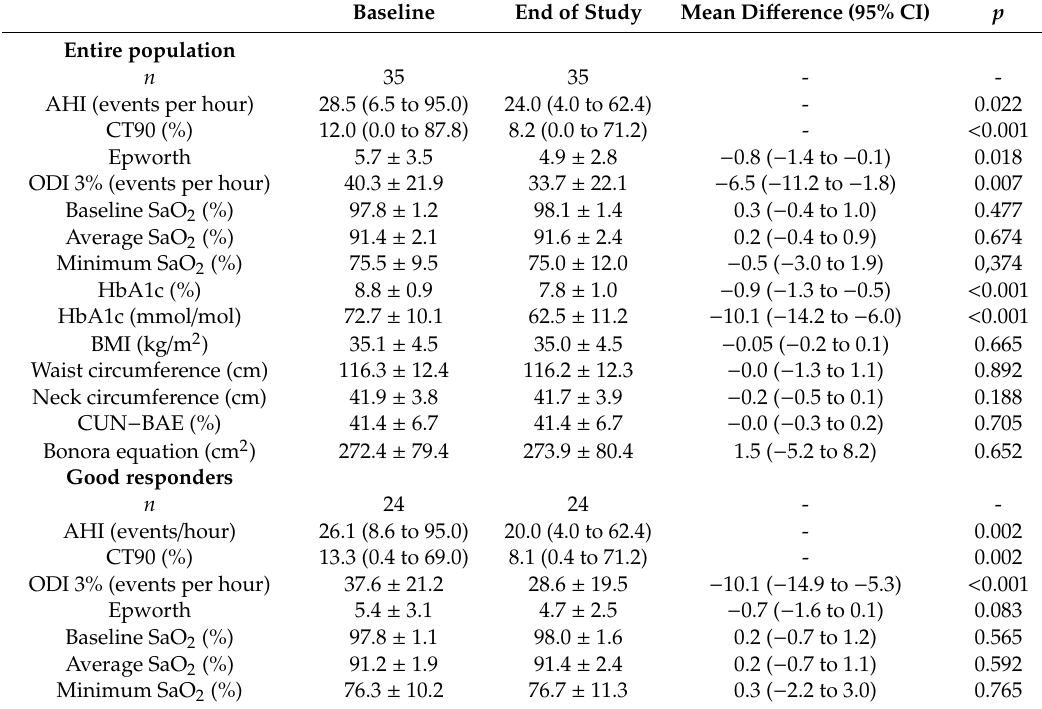
Table 1. Evolution of the main nocturnal sleep breathing parameters according to the response to the intensification of the antidiabetic